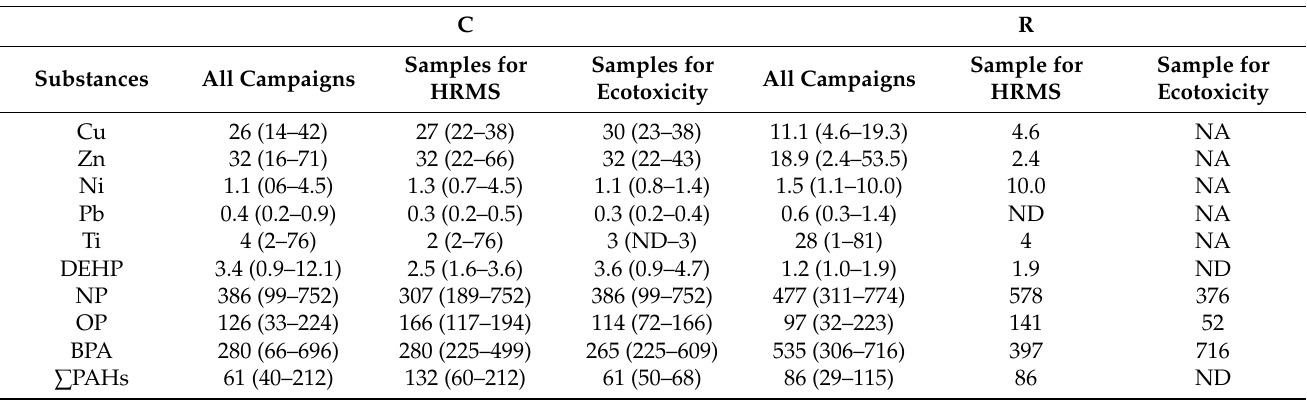
Table 2. Summary of targeted analyses of runoff samples (dissolved phase) from the C and R sites: median, min and max concentrations ( µ g/L) measured for all samples collected at these sites ([43], doi:10.17632/m8kcmthfd2.1) and for samples used in this work. All analyses were not systemat- ically performed from all samples (due to volume limitations) (NA = calculation not applicable). DEHP = di(2-ethylhexyl)phthalate; NP = 4-nonylphenol; OP = 4- tert -octylphenol; BPA = bisphenol A; ∑ PAHs = sum of 16 polycyclic aromatic hydrocarbons; C = Compans site; R = Rosny site; ND = not detected (<limit of